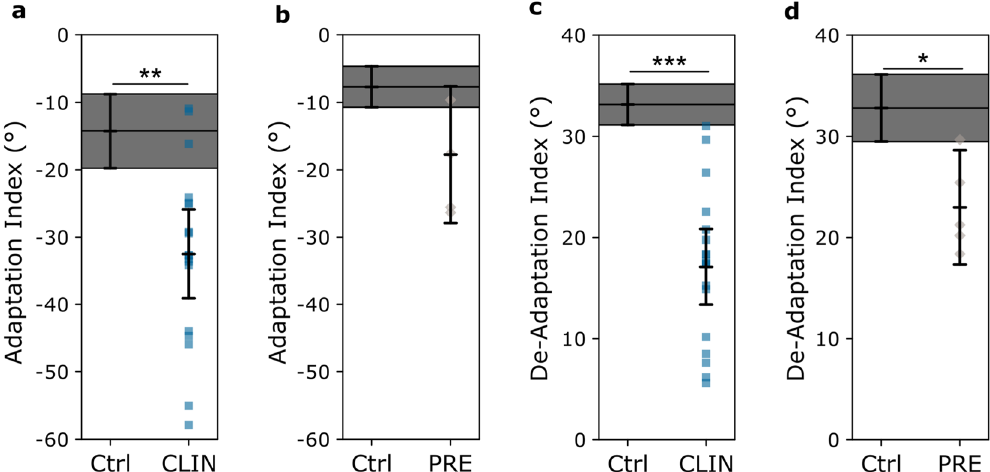
Figure 5. Adaptation Index (AI) and De-Adaptation index (DeAI) for the CLIN patients ( a,c ) and the PRE individuals ( b,d ). The individual values of the AI and DeAI are represented for the CLIN patients (blue squares) and for the PRE individuals (grey diamonds). Error bars represent the 95% confidence interval of the mean. The grey shaded area corresponds to the 95% confidence interval of the mean for the control groups. Statistically significant differences between control groups and patients are represented as follows: * p < 0.05, ** p < 0.01 and *** p < 0.001 (Bootstrap independent samples